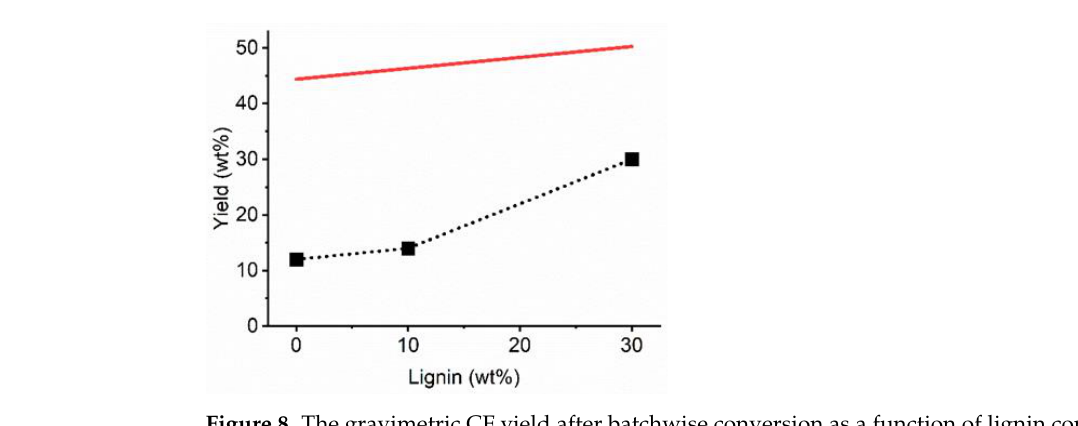
Figure 8. The gravimetric CF yield after batchwise conversion as a function of lignin content in the System S precursor. The red line shows the theoretical carbon yield based on the carbon content of the raw materials.